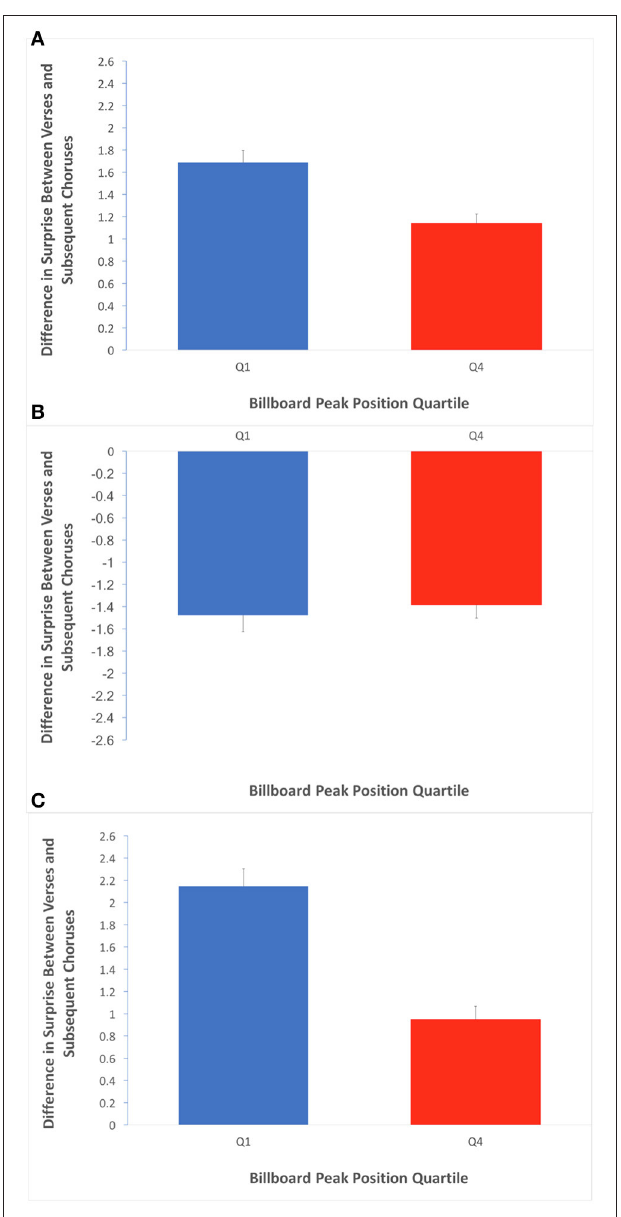
FIGURE 8 | Average difference in surprise between verse preceding a chorus and their subsequent choruses. Error bars are standard errors. (A) Average of absolute values of differences in surprise over the verse/chorus transitions, for Q1 and Q4. The greater value in Q1 is consistent with an effect of contrastive surprise localized in the verse/chorus pairs. (B) Average of negative subset of differences when chorus surprise is subtracted from verse surprise. The lack of a quartile effect here suggests any contrastive-surprise effect between verses and choruses is not bidirectional. (C) Average of positive subset of differences when chorus surprise is subtracted from verse surprise. The greater value in Q1 is consistent with a contrastive-surprise effect that involves a drop in surprise from verse to subsequent chorus, specifically.